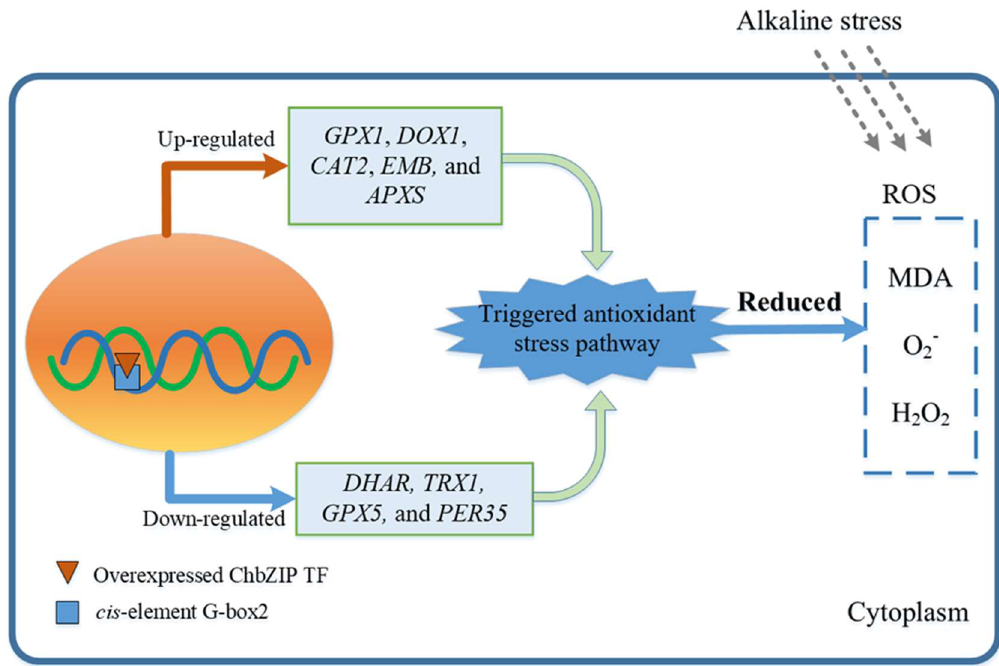
Figure 8. The proposed alkaline tolerance mechanism in Arabidopsis with overexpressed ChbZIP1 TF.